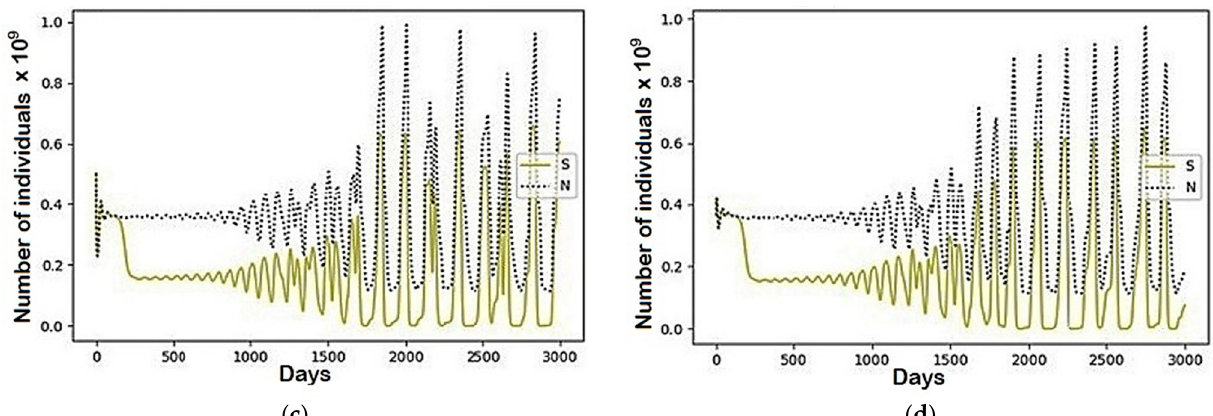
Figure A1. The modeling results describing the total population size (N) and the population belonged to the susceptible (S) group using the parameters represented in Table 1: ( a ) Region 1; ( b ) Region 2; ( c ) Region 3; ( d ) Region 4.